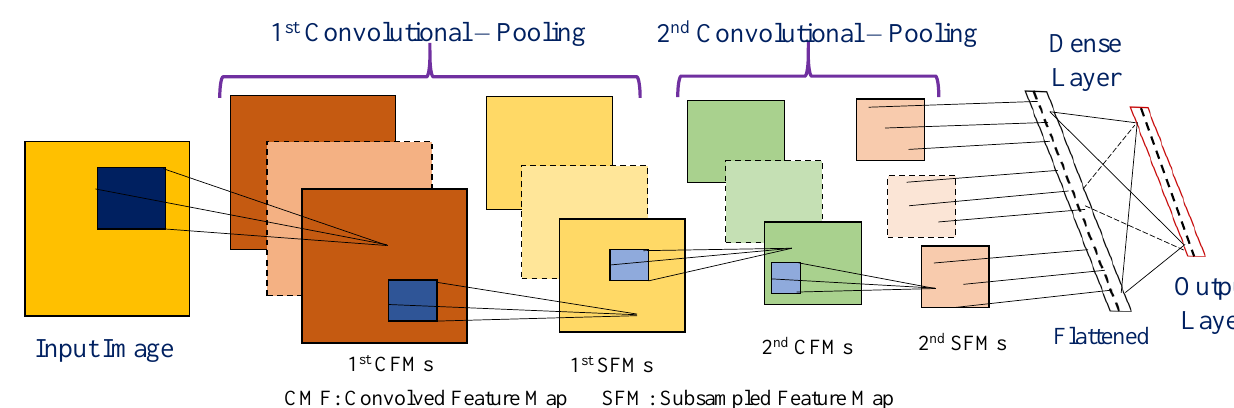
Figure 1. The generic architecture of a convolutional neural network with two convolutional-pooling layers.